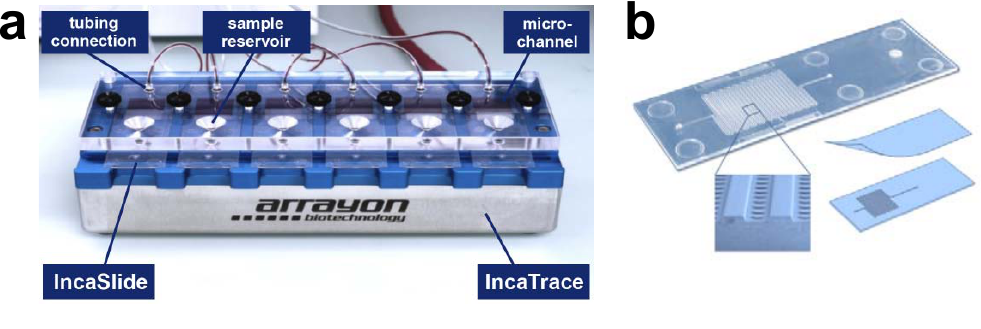
Figure 1. Inca Bioanalytical System. ( a ) The IncaTrace instrument is equipped with an integrated heating plate. Six IncaSlides are mounted on the IncaTrace instrument and connected via Tygon ST tubings to a multi-channel peristaltic pump; ( b ) IncaSlide with microstructured channel architecture and lamination. The inset shows a section (SEM image) of substructured microchannels. The diameter of the protruding posts is 300